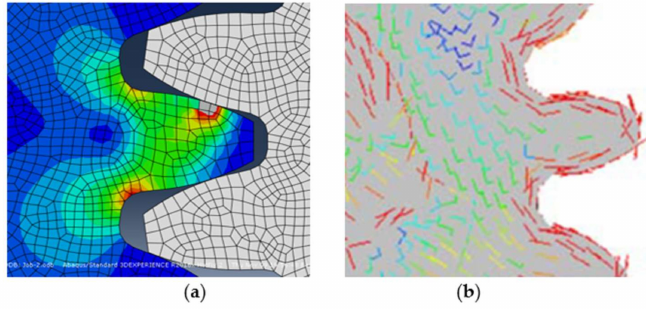
Figure 25. ( a ) Maximum principal stresses; ( b ) principle directions at spur gear tooth region.